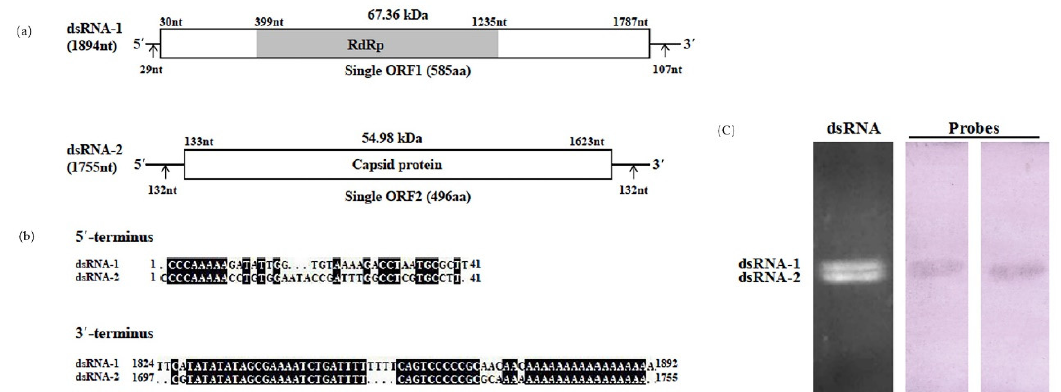
Figure 2. Molecular characteristics of RsRV5. ( a ) Schematic diagram of the genomic organization of RsRV5; ( b ) Multiple alignment of the terminal regions of RsRV5 genome; ( c ) Northern blot detection of dsRNA-1 and dsRNA-2 using digoxigenin-labeled probes 1 and 2.